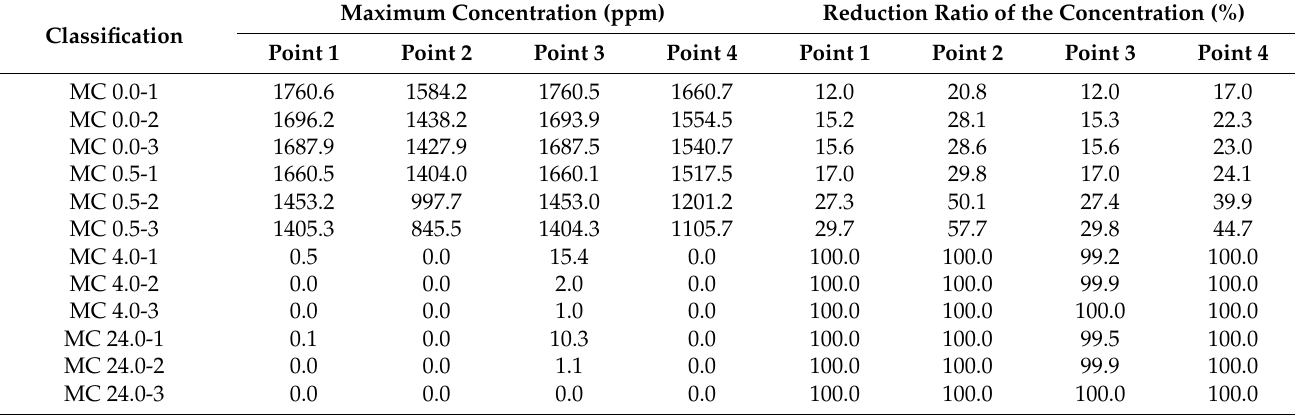
Table 6. FDA results for the medium-TPH condition.